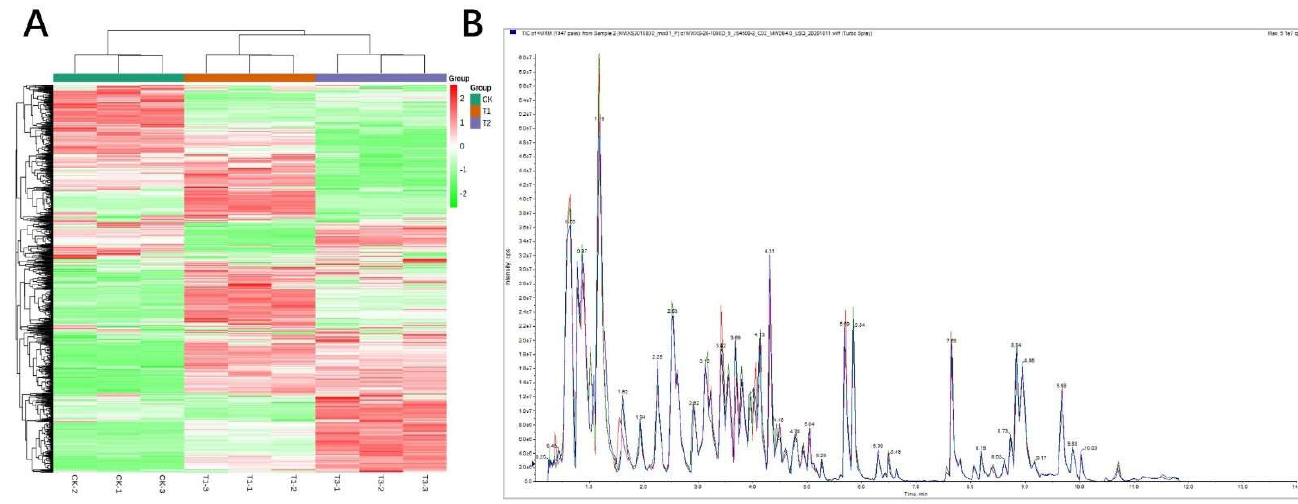
Figure 2. Cluster heat maps and total ions’ current chromatograms of control maize plants and those exposed to T1 and T2 water stress treatments. T1 (drought stress at seedling stage), T2 (drought stress at flowering stage), CK (conventional irrigation). ( A ) cluster heat map of all the metabolites in T1, T2 and CK; ( B ) overlay chromatogram of total ion current chromatograms (TIC) for mass spectrometric detection of quality control (QC) samples. Table 1. Statistics of differentially abundant